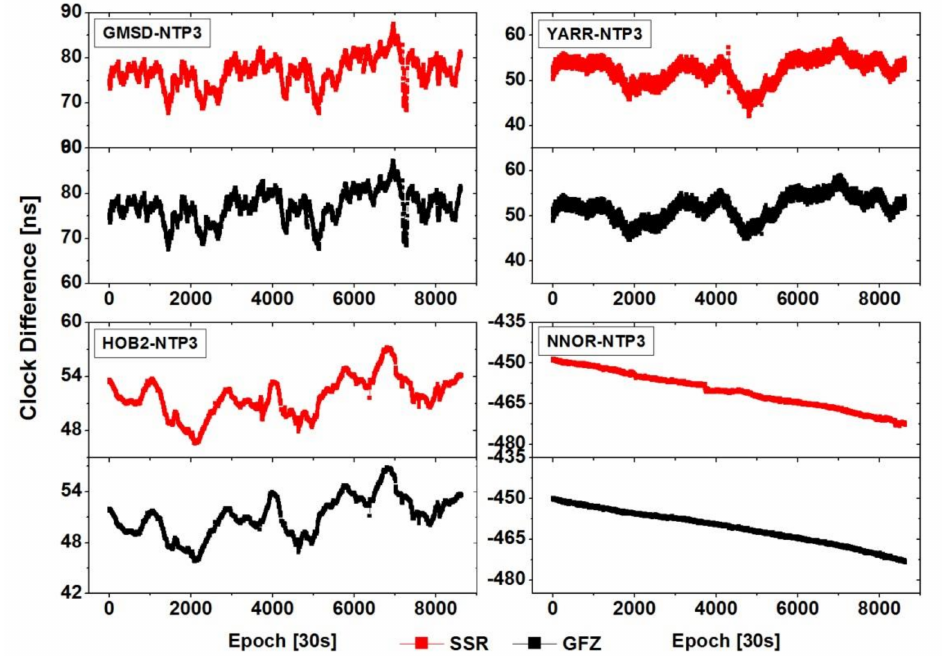
Figure 11. Galileo results for SSR and GFZ